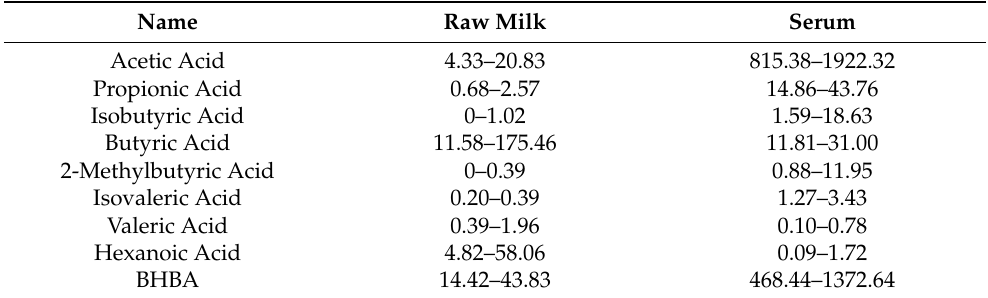
Table 4. Concentration range ( µ mol/L) of BHBA and SCFA in raw milk ( n = 19) and serum ( n =